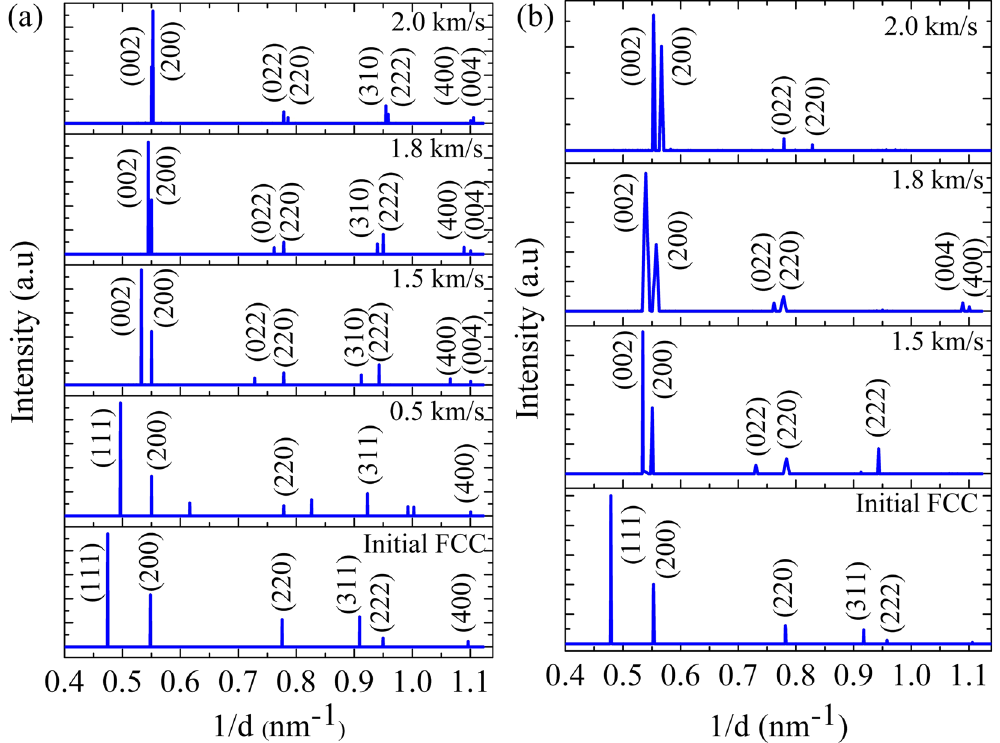
Figure 5. X-ray diffraction patterns Cu along 〈 100 〉 crystallographic direction at ambient temperature and pressure as well as shock compressed conditions at different piston velocities demonstrating structural phase transition: ( a ) Results obtained from classical MD simulations (which includes both NEMD and MSST simulations) ( b ) Results obtained from ab − initio MD